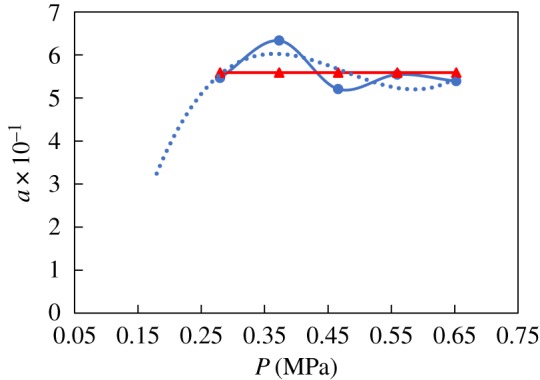
Fitting of constant a2 and pressure.